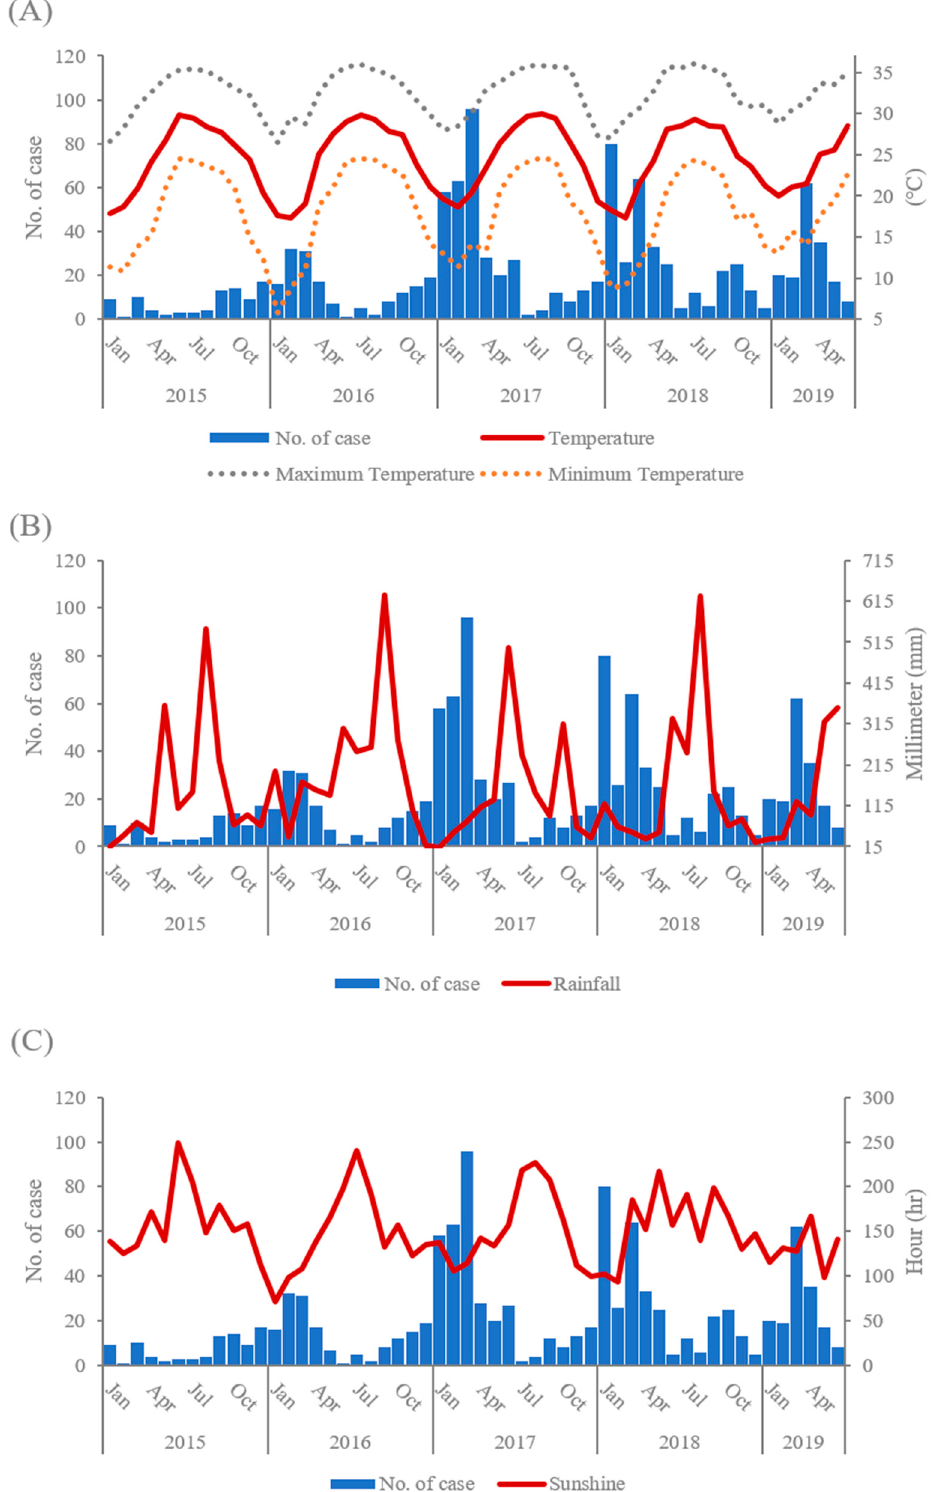
Figure 1. Trends in norovirus infections over time and average daily temperature ( A ), rainfall ( B ), and sunshine ( C ) in Taiwan, 2015–2019.